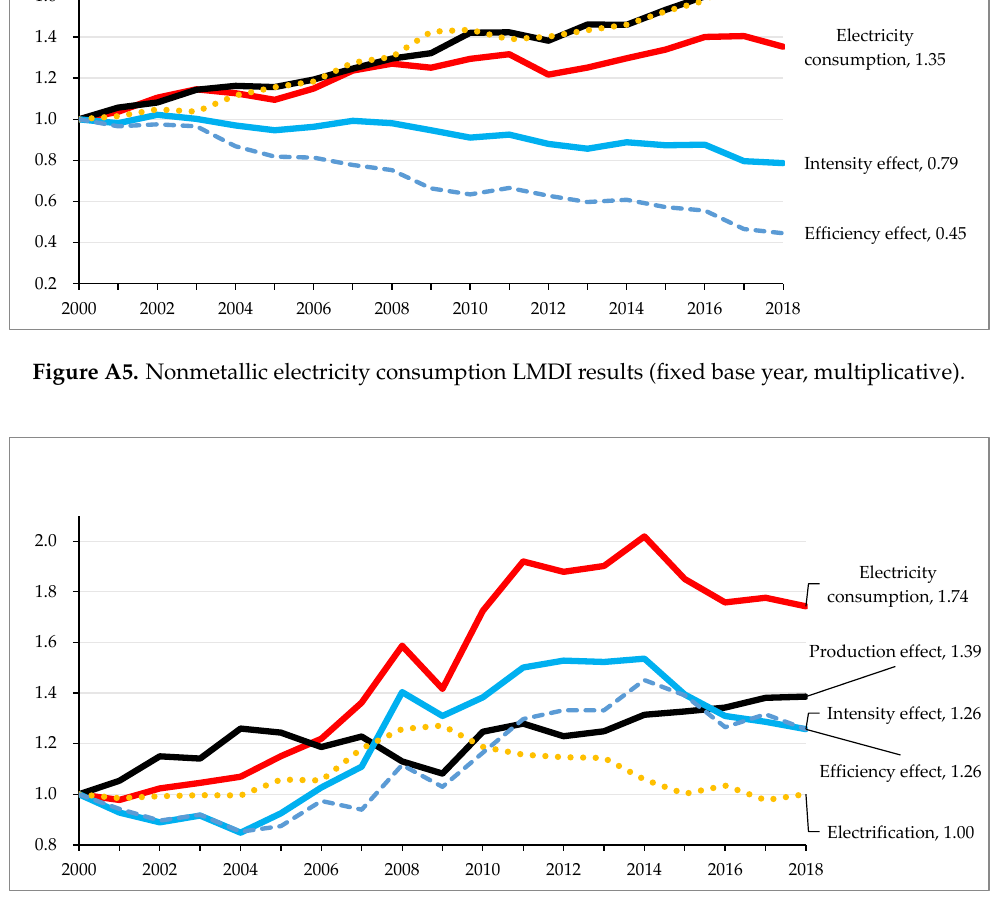
Figure A6. Basic metal electricity consumption LMDI results (fixed base year, multiplicative).